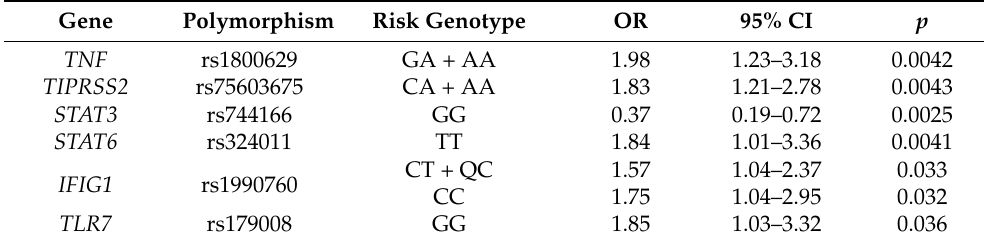
Table 5. Markers associated with the risk of mild or asymptomatic to more severe disease (subgroup A1 (healthy + asymptomatic + mild) vs. subgroup A2 (medium + severe)).